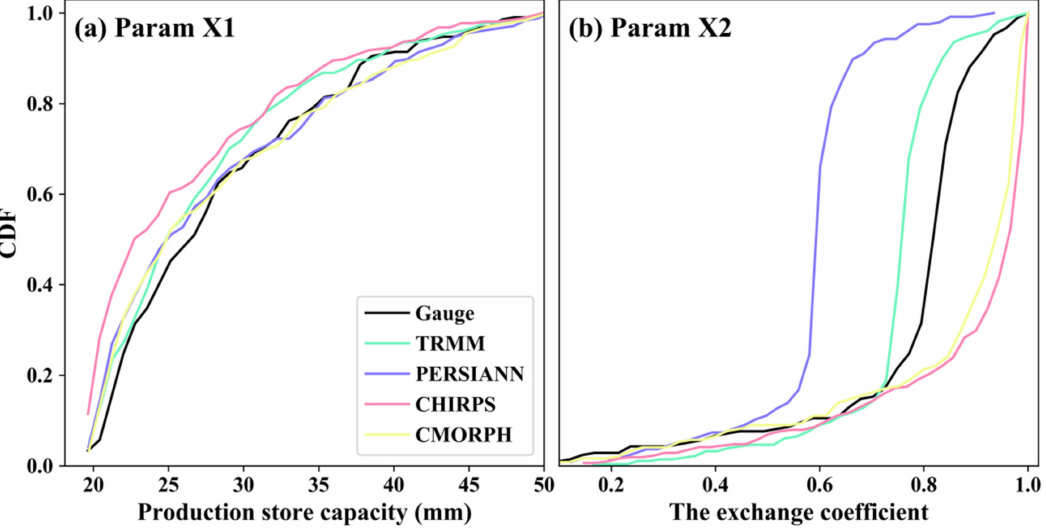
Figure 15. The Cumulative Distribution Function (CDF) of model parameters for all products and gauges: ( a ) parameter X1 represents the capacity of production; ( b ) parameter X2 represents the exchange